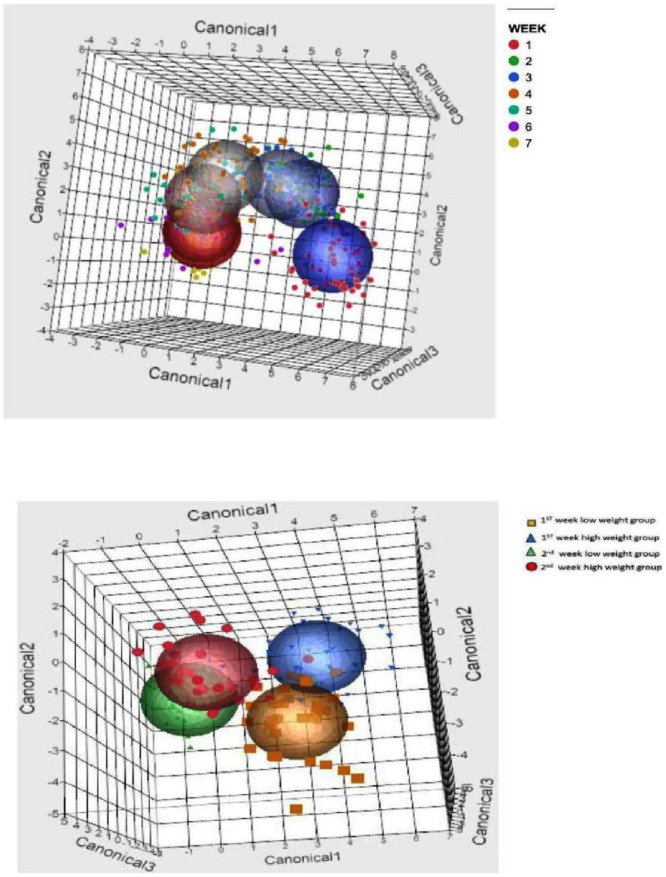
Discriminant analysis of fecal microbiomes by week of life.The microbial transition from week one (blue circle) until week seven (red circle) is illustrated by the circles, and individual data points are also depicted. Discriminant analysis was performed in JMP Pro (SAS Institute Inc., North Carolina) using bacterial genus prevalences as covariates and week of life as the categorical variable (top). Discriminant analysis of fecal microbiomes by weight gain-group and first and second week of life. First week microbiota was a strong predictor of weight gain from birth through the seventh week of life. Discriminant analysis was performed in JMP Pro (SAS Institute Inc., North Carolina) using bacterial genus prevalences as covariates and the interaction of weeks1 and 2 and weight gain (low and high) as the categorical variable (bottom).